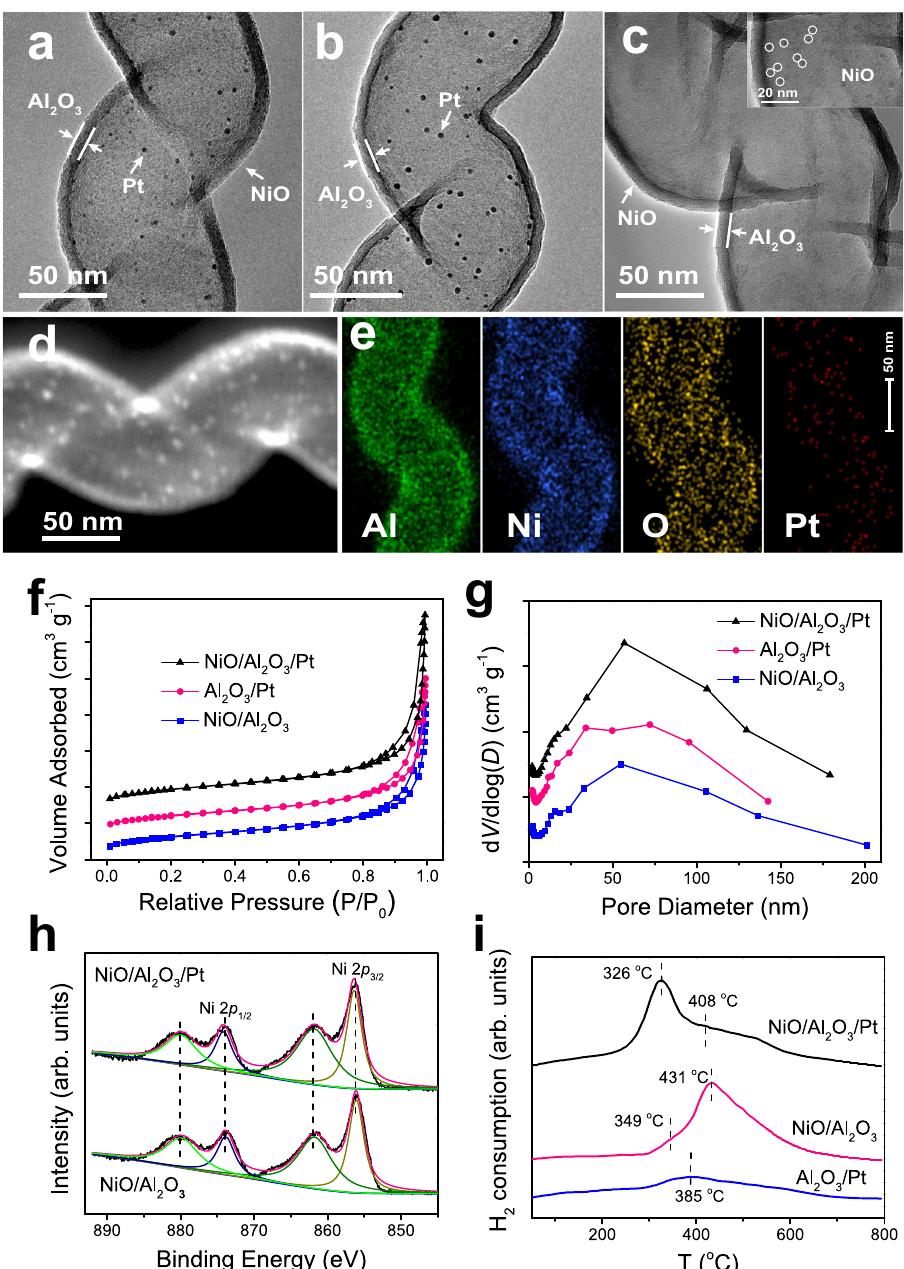
Fig. 1 Structure and chemisorption characterization of the catalysts. TEM images of a NiO/Al 2 O 3 /Pt, b Al 2 O 3 /Pt, and c NiO/Al 2 O 3 catalysts. Inset in c shows a HRTEM image of NiO/Al 2 O 3 . d HAADF-STEM image and e EDX elemental mapping of the NiO/Al 2 O 3 /Pt catalyst. f N 2 adsorption − desorption isotherms and g the corresponding pore size distributions of the catalysts. h XPS Ni 2 p analysis of NiO/Al 2 O 3 and NiO/Al 2 O 3 /Pt. i H 2 -TPR pro fi les of NiO/ Al 2 O 3 , Al 2 O 3 /Pt, and NiO/Al 2 O 3